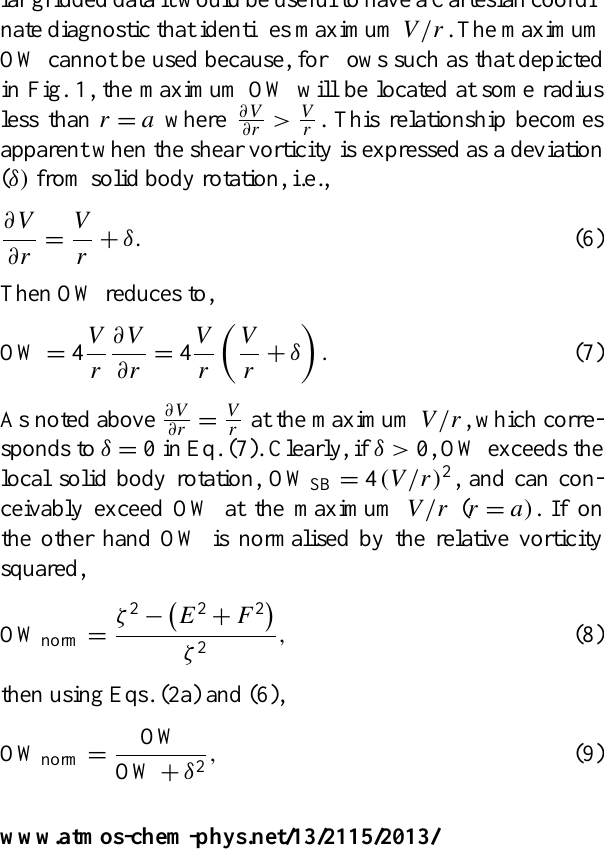
Fig. 1. Schematic representation of a hypothetical tangential wind ( V ) profile (blue curve) with radius ( r ). The green line at r = a de- picts the radius of maximum V , which is defined by the slope of the r = ∂V purple curve. At r = a , V , the flow is in solid body rotation r ∂r and OW norm = 1. Inside r = a the area-averaged vorticity is maxi- mized, which is deemed to be the most favourable region for TC for- mation. The red line depicts the radius of maximum wind (RMW) where OW norm = 0, beyond which deformation exceeds vorticity and the environment is deemed to be hostile to TC formation.